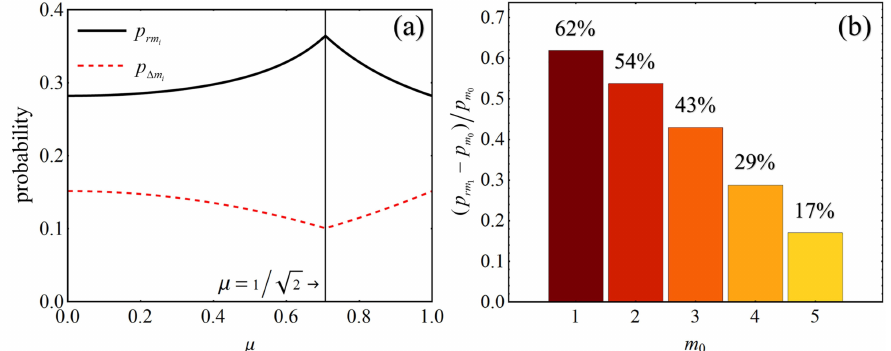
Figure 3. ( a ) Relative detection probability and crosstalk probability of the signal photon versus initial probability amplitude µ ( z = 50 m, ∆ m i = 1); ( b ) ( p rm numbers m 0 ( z = 100 m).